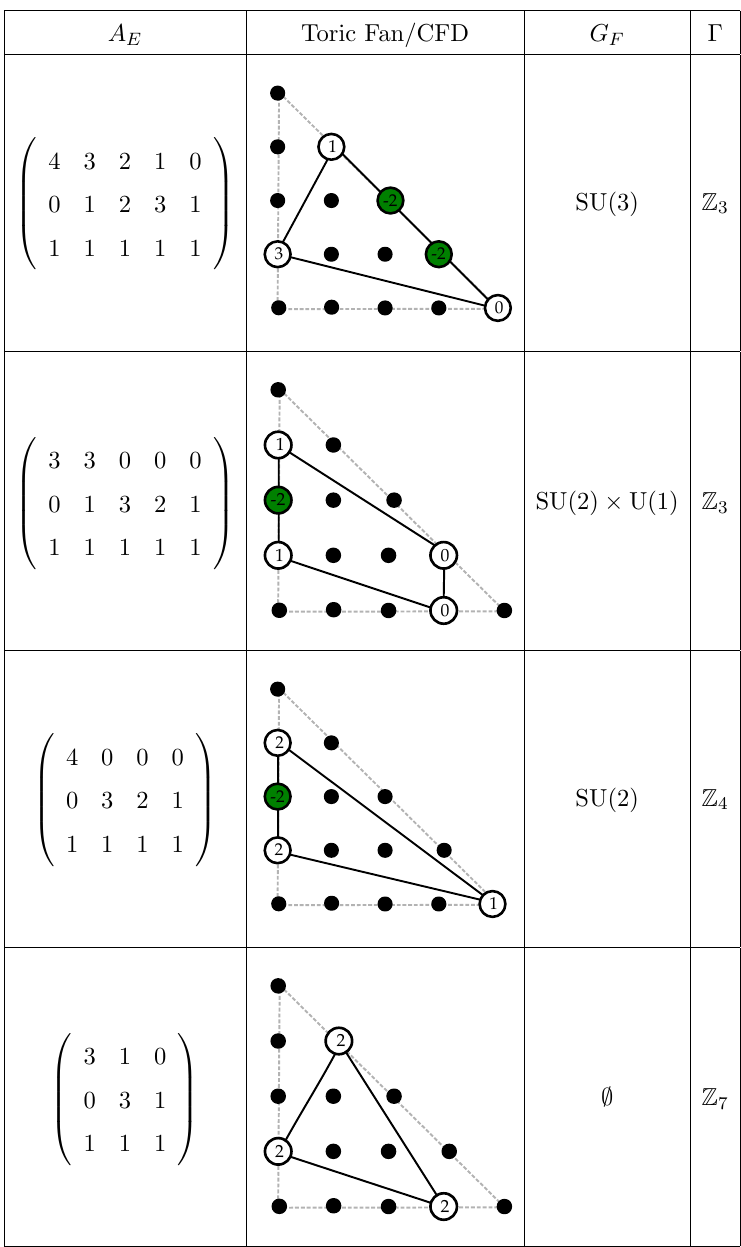
Table 2 . Descendants of the T 4 theory, which have non-trivial 1-form symmetry. First we give the toric vectors for the vertices of the curves in the toric diagram and its boundary, which is the CFD, that is shown in the second column. The (cid:13)avor symmetry is indicated by G F and (cid:0) is the 1-form symmetry.